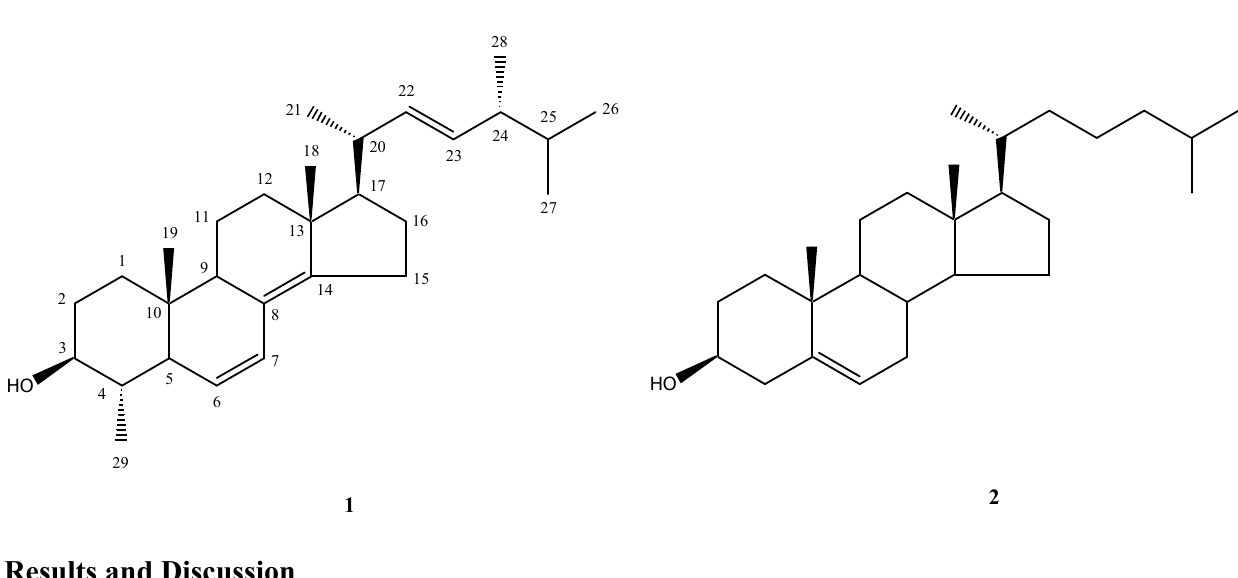
Figure 1. Structures of compounds 1 and 2